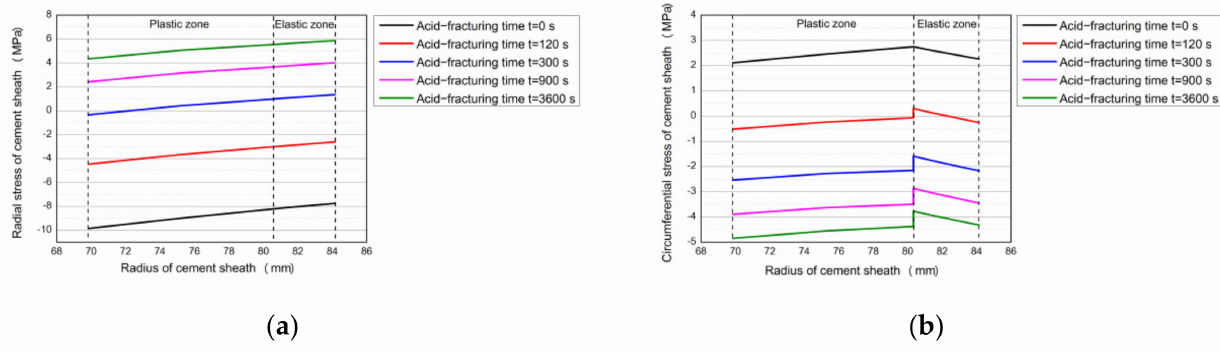
Figure 11. Combined stress of cement sheath during acid fracturing. ( a ) Radial combined stress; ( b ) Circumferential combined